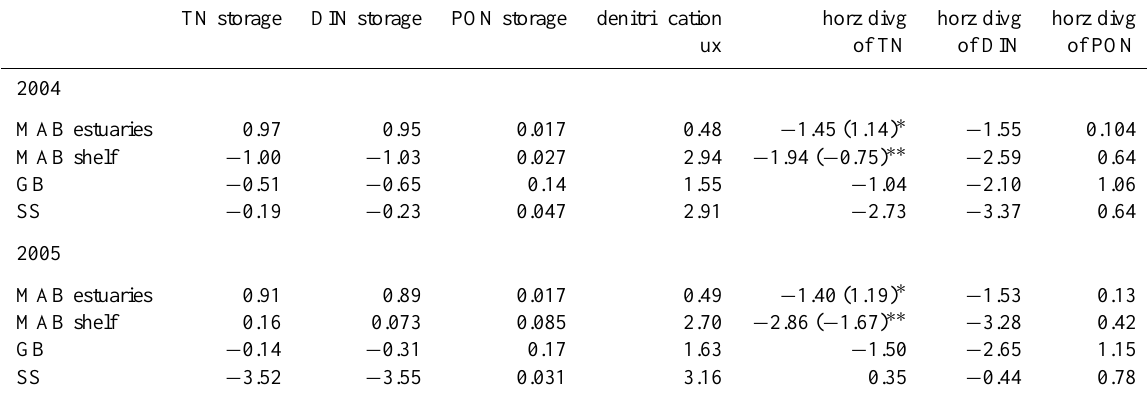
Table 1. Model-based nitrogen budget for the Middle Atlantic Bight (MAB) estuaries, the MAB shelf, Georges Bank (GB) and the Scotian Shelf (SS) for 2004 and 2005. All fluxes are in 10 10 molNyr − 1 . TN storage DIN